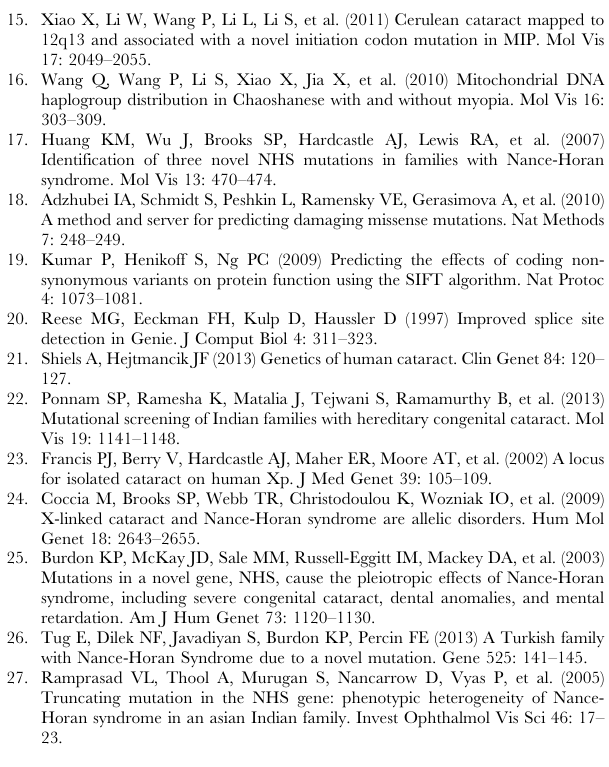
Figure S1 Sequence chromatography. The family number was shown in the left column. Sequences with mutations from patients and normal controls were shown in the middle and right